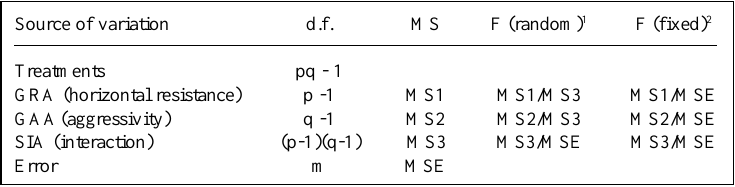
Table III - Analysis of variance of a partial diallel